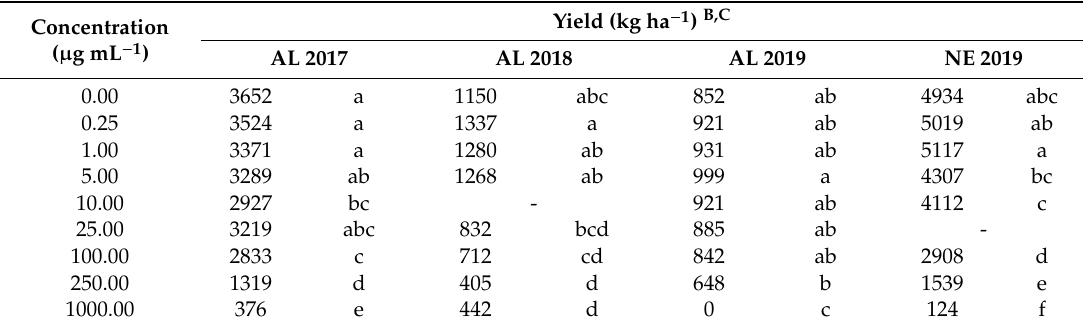
Table 7. Soybean yield response to various dicamba concentrations under field conditions A .